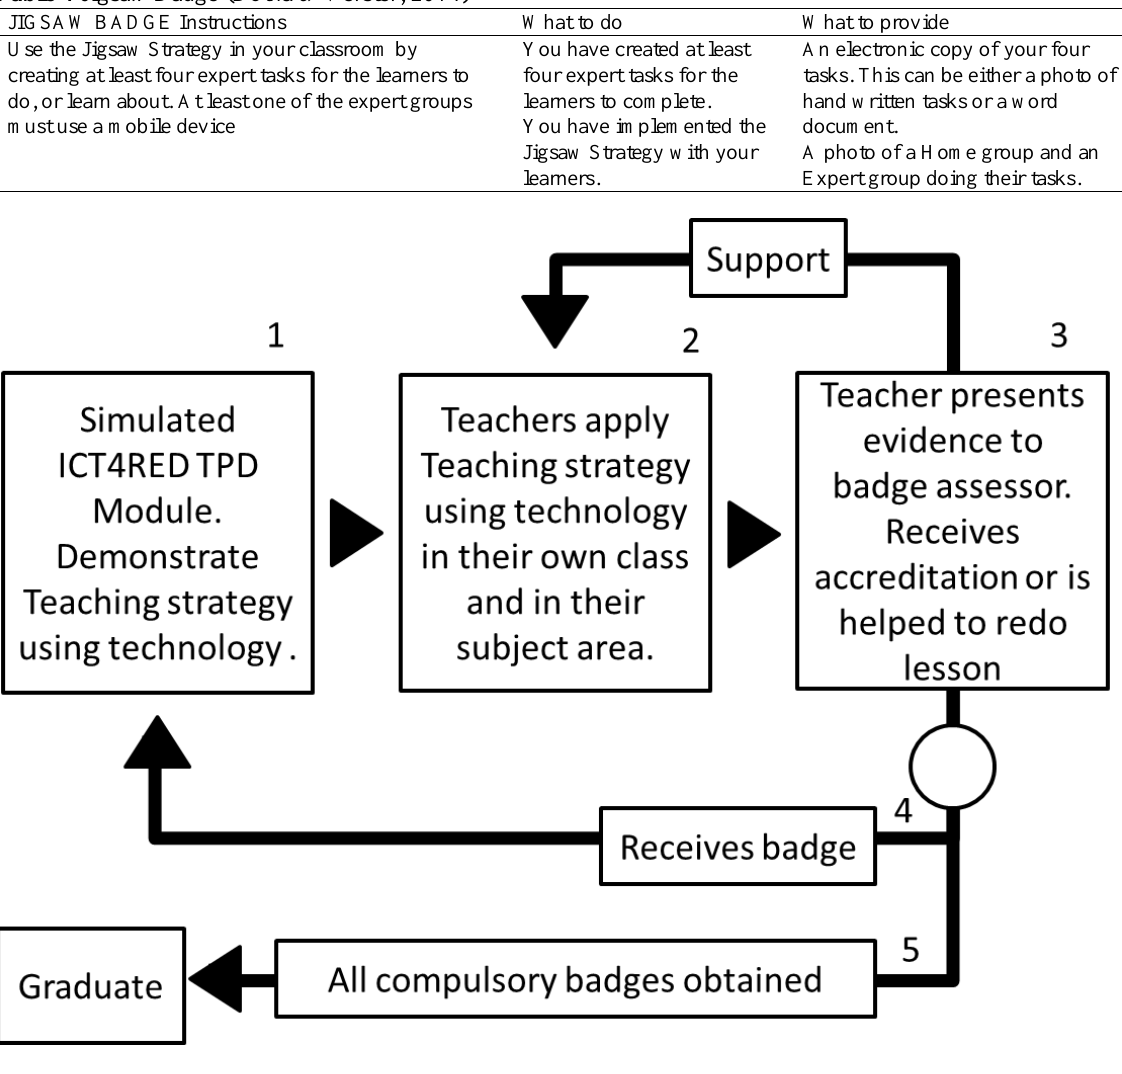
Figure 2 Course methodology (Botha, 2014)